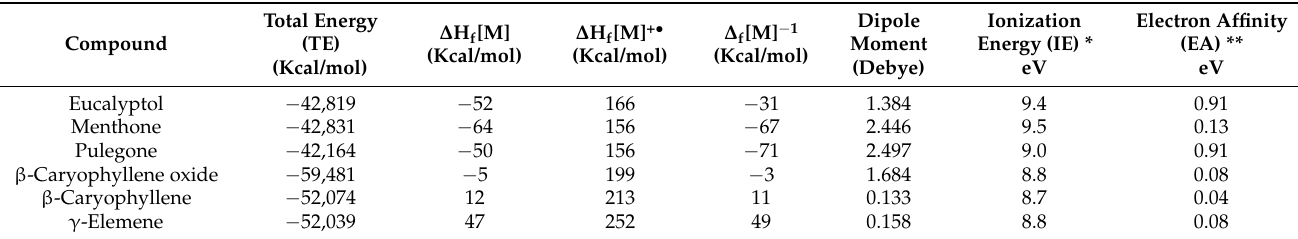
Table 3. Thermodynamic data of the studied molecules, calculated within the modified neglect of the diatomic overlap (MNDO)